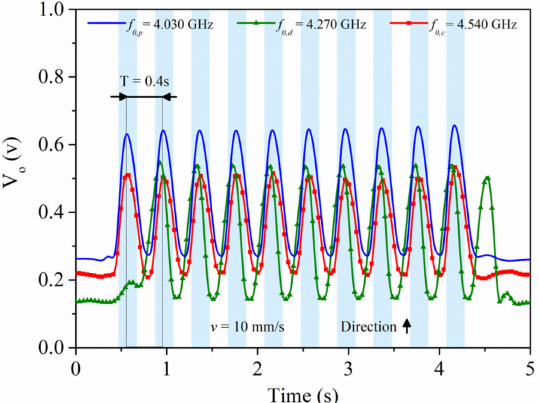
Figure 29. Measured envelope functions for encoder motion at a constant velocity of v = 10 mm/s in the upper direction (according to the sketch of Figure 25), corresponding to the encoder implemented on polycarbonate of Figure 28. The considered vertical distance between the encoder and the reader is 1